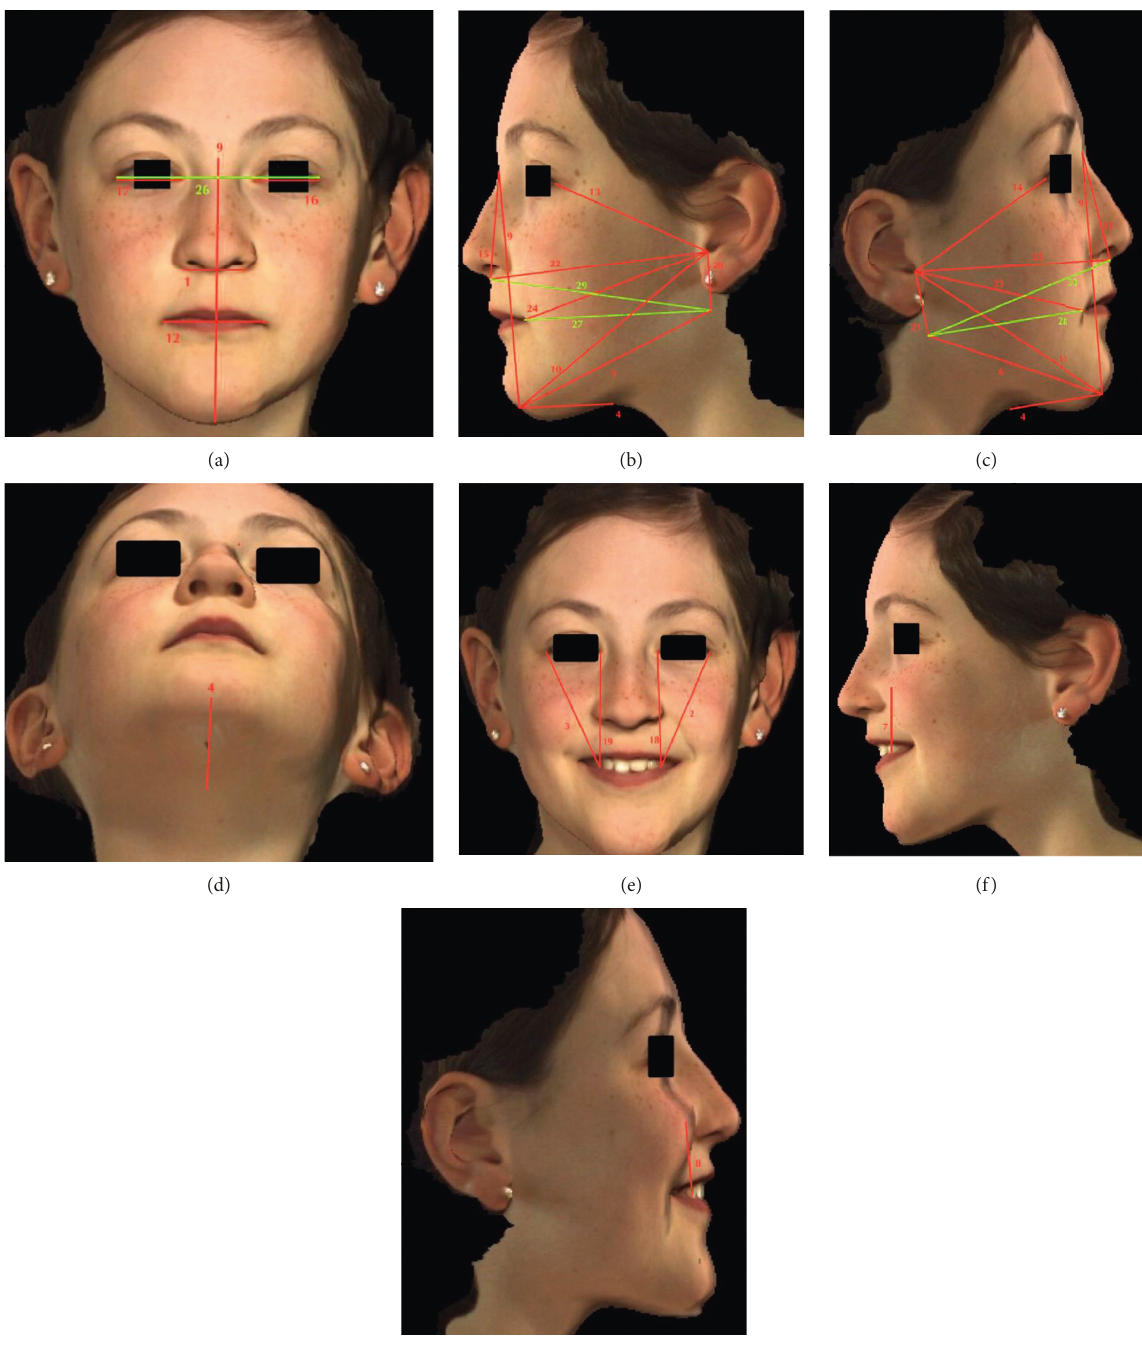
Figure 2: Frontal, left lateral profile, right lateral profile, inferior, frontal smiling, left lateral profile smiling, and right lateral profile smiling views of the facial scanner image, with numbered areas corresponding to landmarks. (a) Frontal View. (b) Left lateral profile view. (c) Right lateral profile view. (d) Inferior view. (e) Frontal view, smiling. (f) Left lateral profile view, smiling. (g) Right lateral profile view,